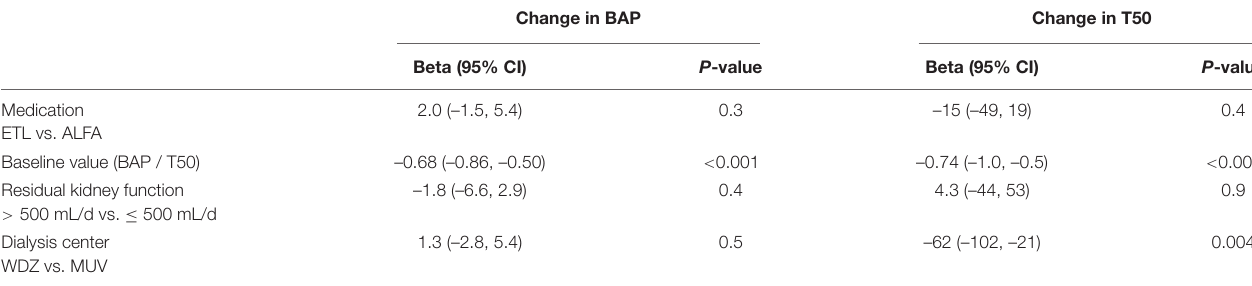
TABLE 2 | ANCOVA models for change in BAP and serum calcification propensity score test (T50) from baseline to study end.